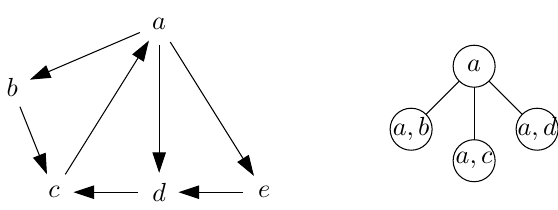
Fig. 1: A digraph (left) with its d-decomposition of width one